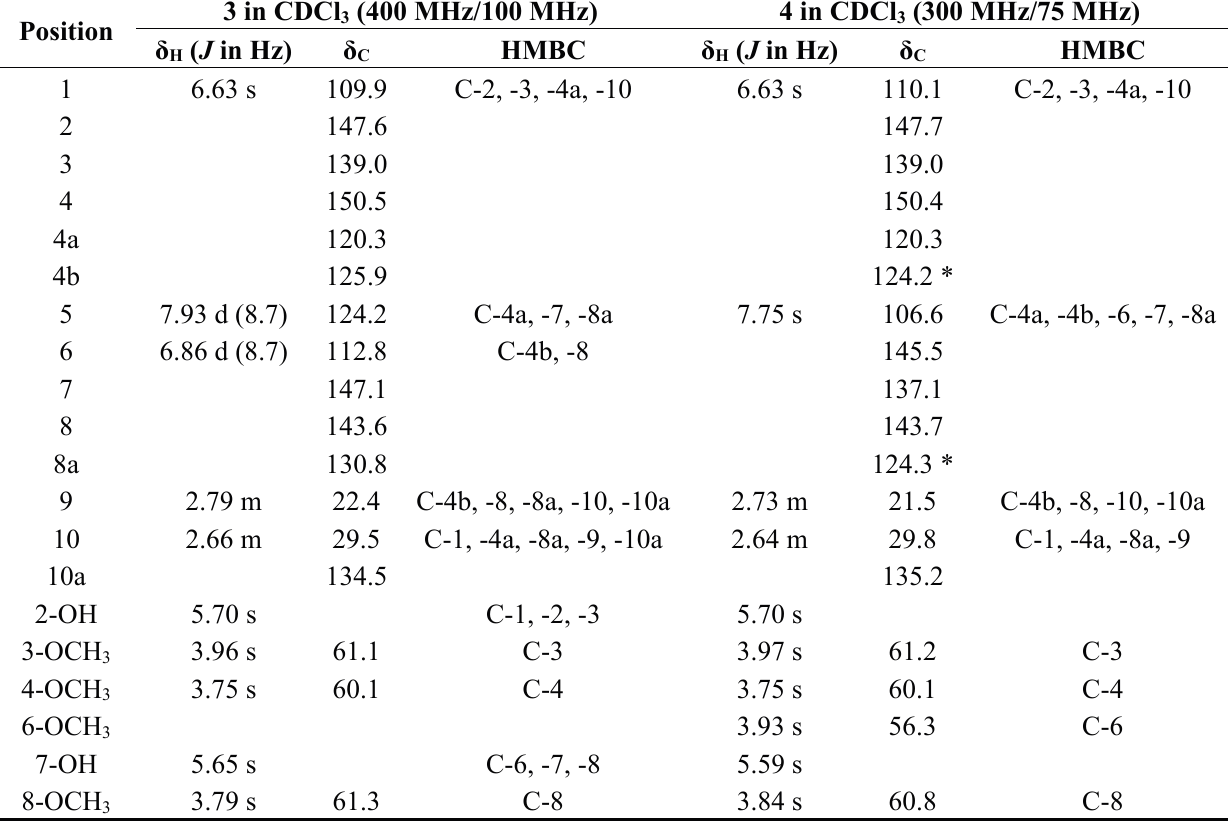
Table 2. 1 H and 13 C NMR Spectroscopic Data and HMBC Correlations for Cephathrenes 3 and 4